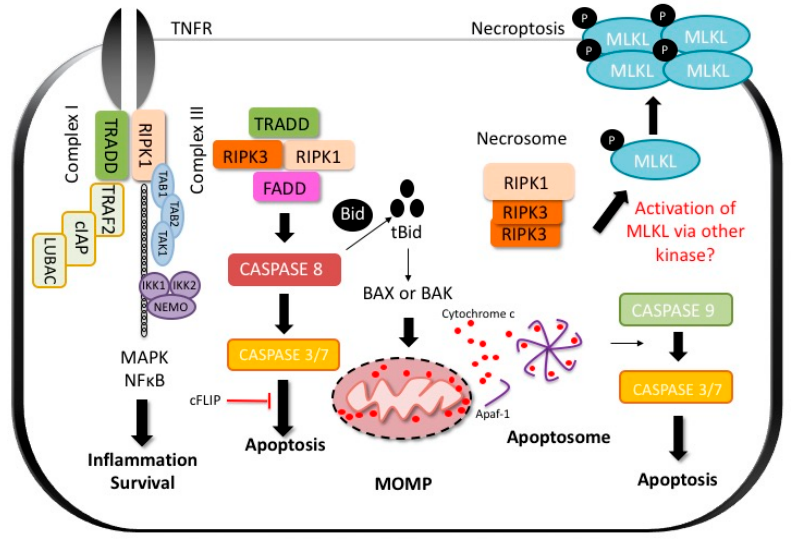
Figure 1. Tumor necrosis factor (TNF) receptor-mediated cell death. TNF binding to TNF receptor (TNFR) results in the formation of complex I which includes TNFR-associated death domain (TRADD), receptor interacting protein kinase-1 (RIPK1), TNFR-associated factor 2 (TRAF2), cellular inhibitor of apoptosis 1 (cIAP1), cellular inhibitor of apoptosis 2 (cIAP2) and linear ubiquitin chain assembly complex (LUBAC). RIPK1 is ubiquitinated resulting in the formation of a platform and recruitment of the I κ B kinase (IKK) complex (NF κ B Essential Modulator (NEMO), IKK1 and IKK2) and TAB (TAK1-binding protein)/TAK-1 (transforming growth factor- β -activated kinase 1) complexes. This results in the activation of NF κ B and mitogen-activated protein kinase (MAPK). For apoptosis to occur, the cytoplasmic Complex II is formed which can have two forms. Complex IIa is made up of TRADD, FADD (fas-associated protein with death domain) and caspase-8 and complex IIb consists of RIPK1/RIPK3, FADD, caspase 8 and FLICE-like inhibitory protein long form (FLIPL). Complex II leads to caspase-8-mediated activation of caspase 3/7 and apoptosis in type I cells such as lymphocytes. In type II cells such as hepatocytes, caspase 8 mediates cleavage of Bid to cleaved Bid (tBid) resulting in Bax- (Bcl-2-like protein 4) and BAK-mediated (Bcl-2 homologous antagonist/killer) mitochondrial outer membrane permeabilization (MOMP) and Cytochrome C release from mitochondria. Cytochrome C binds to apoptotic peptidase activating factor-1 (APAF-1) releasing its auto-inhibitory hold. APAF-1 oligomerizes to form a wheel-like structure called the apoptosome which activates caspase 9. Caspase 9 in turn activates the effector caspases (caspase 3/7) to induce apoptosis. In certain cells, when caspase-8 is inhibited, the cell switches to an alternative form of cell death termed necroptosis. For necroptosis to occur, RIPK1, RIPK3 and mixed lineage domain like (MLKL) form the necrosome. RIPK3 phospho-activates MLKL, leading to its oligomerization and translocation to the cell membrane to induce pore opening and oncolysis. cFLIP: cellular FLICE-like inhibitory protein.